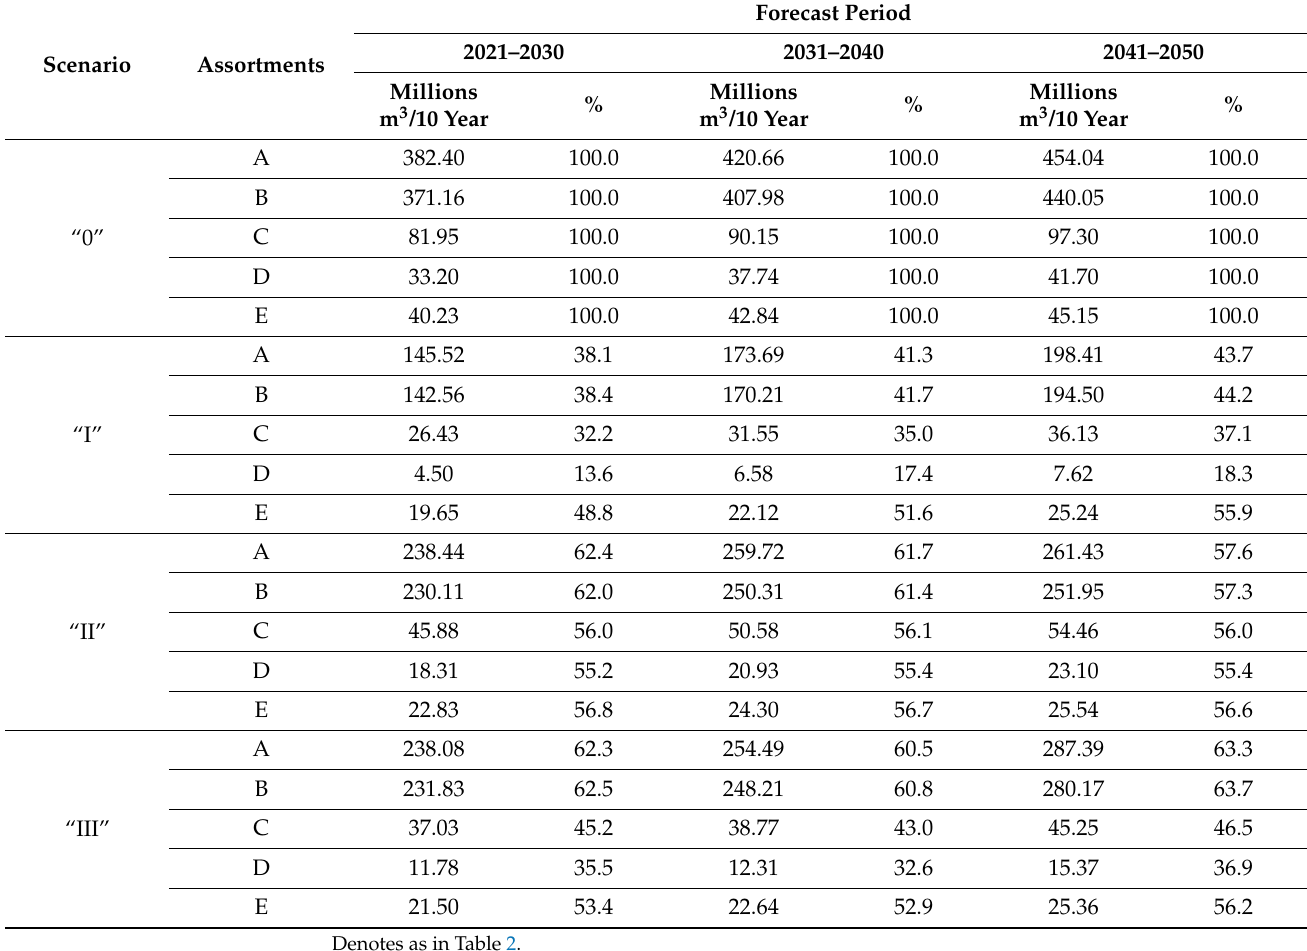
Table 4. Change in logging volume in the scenarios over the three ten-year periods relative to logging volume in the baseline scenario in each of the forecast periods.